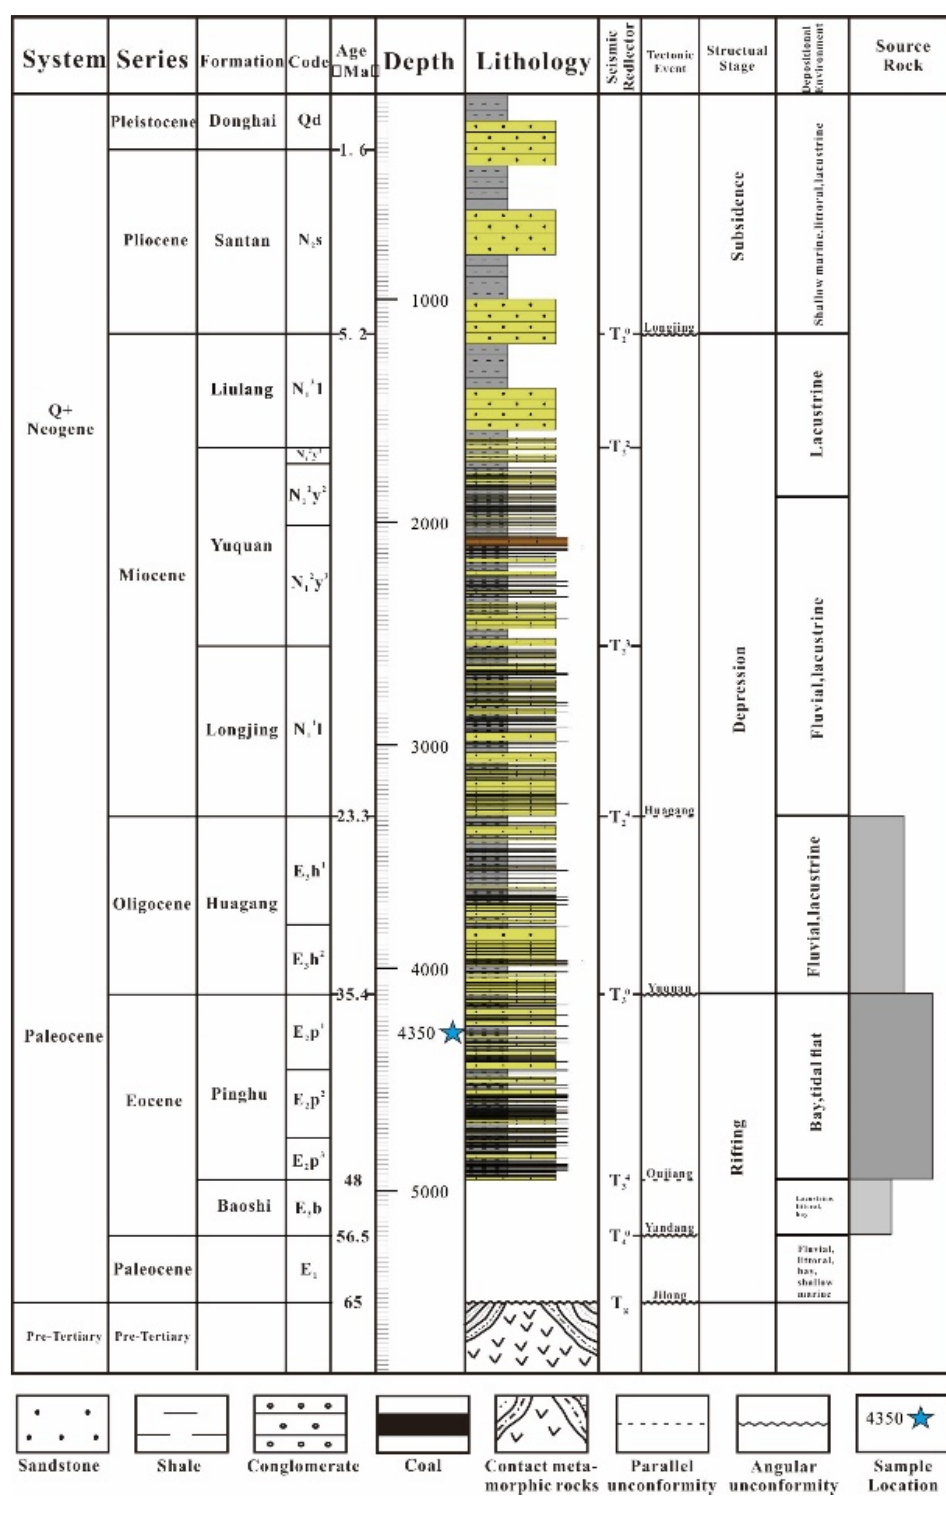
Figure 2. The sedimentary strata drilled in the Xihu Sag.